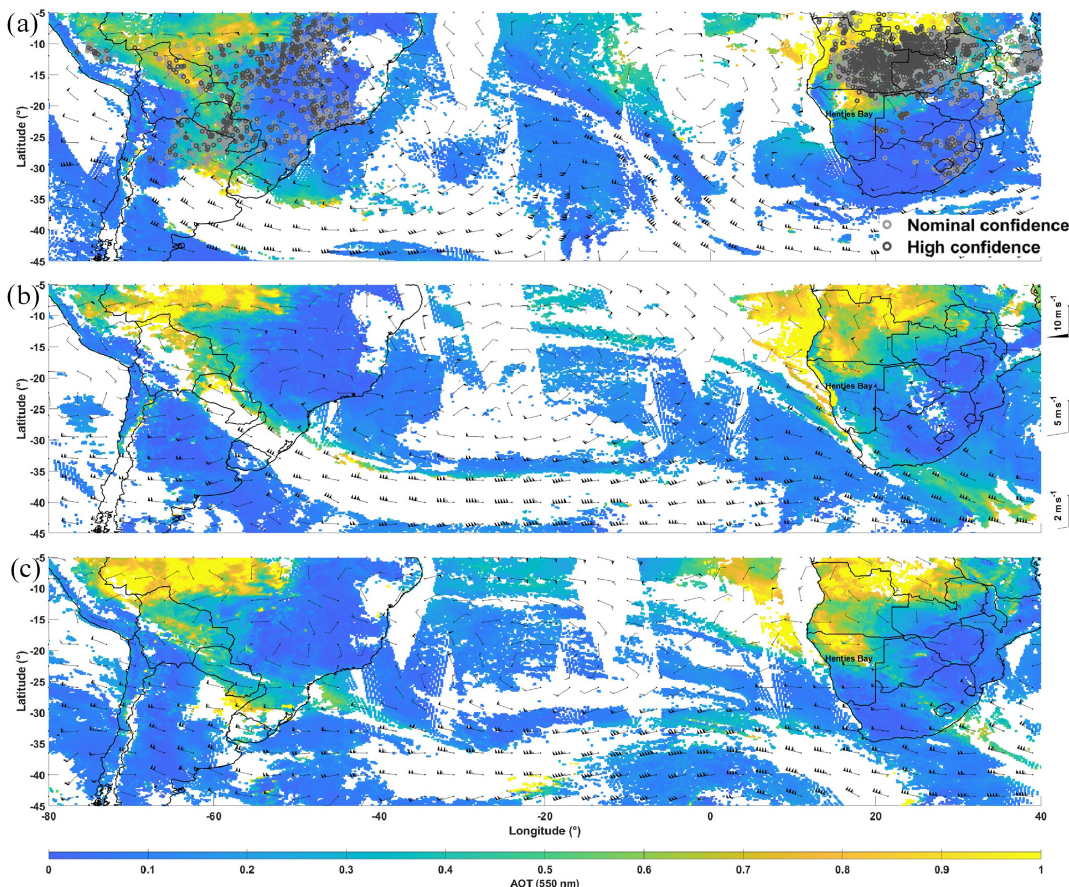
Figure 17. MODIS-derived AOT at 550nm on (a) on 3 September 2017 with wildfire hotspots over both southern Africa and South America, (b) on 5 September 2017 and (c) 6 September 2017. The ERA5 wind fields at 500hPa on each day have been added in black.